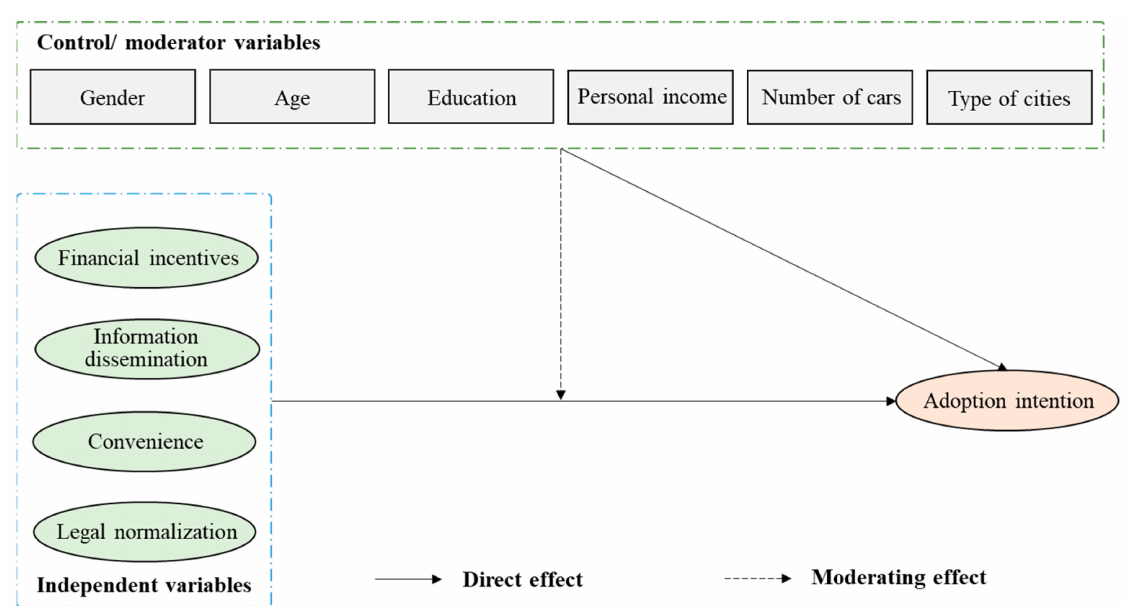
Figure 1. Research framework of relationships among psychological factors, demographic factors, and AV adoption intention.